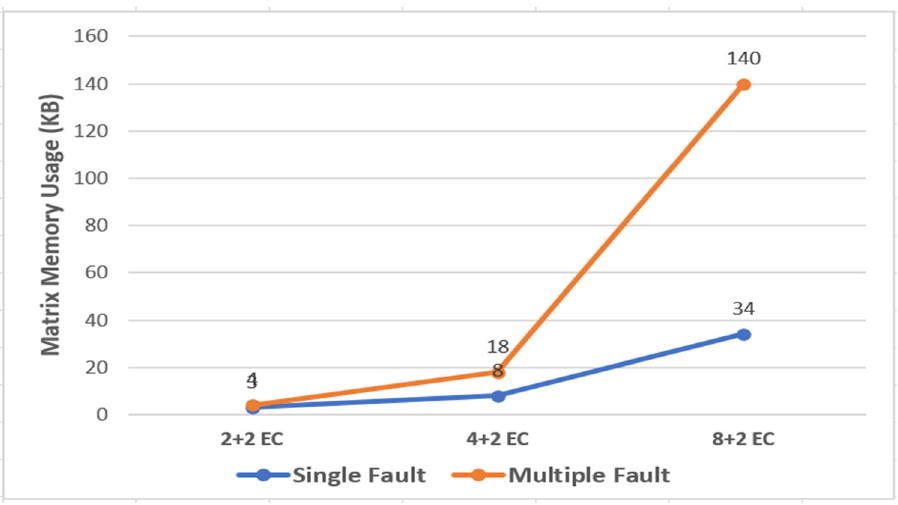
Figure 25. Memory size (KB) needed for matrix storage.